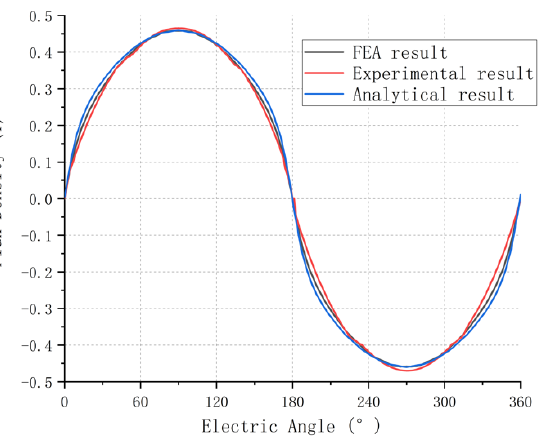
Figure 11. Comparison of the waveforms of the analytical result, FE result and experimental re- sult.